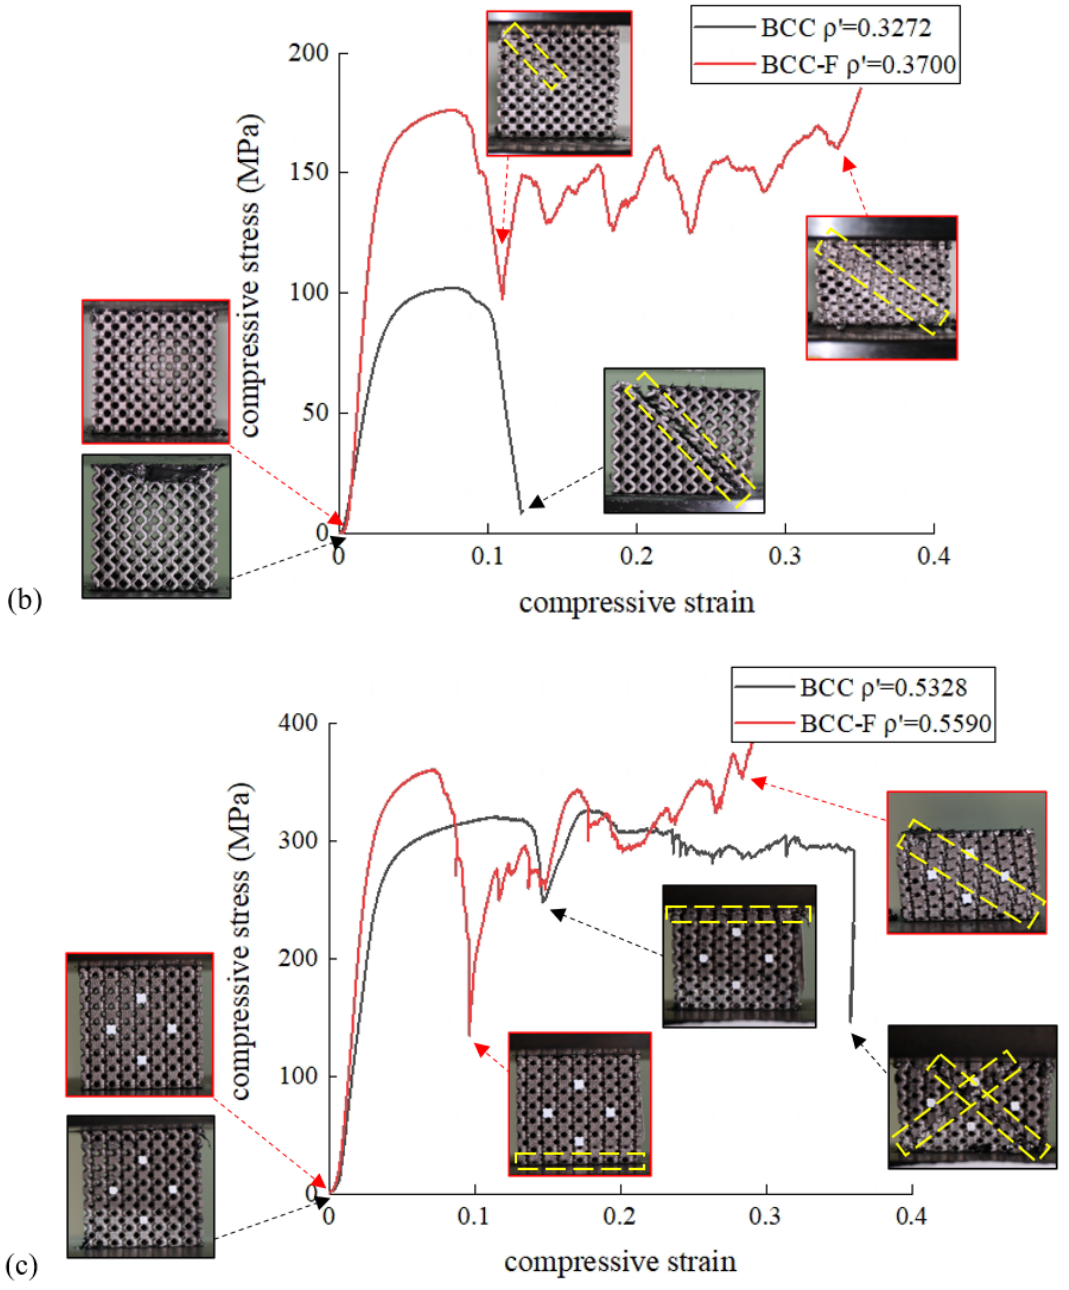
Figure 9. Experimental results of the compressive stress–strain (engineering) curves of specimens of ( a ) BCC lattice with ρ (cid:48) = 0.1150, BCC-F lattice with ρ (cid:48) = 0.1783, ( b ) BCC lattice with ρ (cid:48) = 0.3272, BCC-F lattice with ρ (cid:48) = 0.3700, and ( c ) BCC lattice with ρ (cid:48) = 0.5328, BCC-F lattice with ρ (cid:48) = 0.5590, associated with demonstrations of deformation processes and fracture modes.